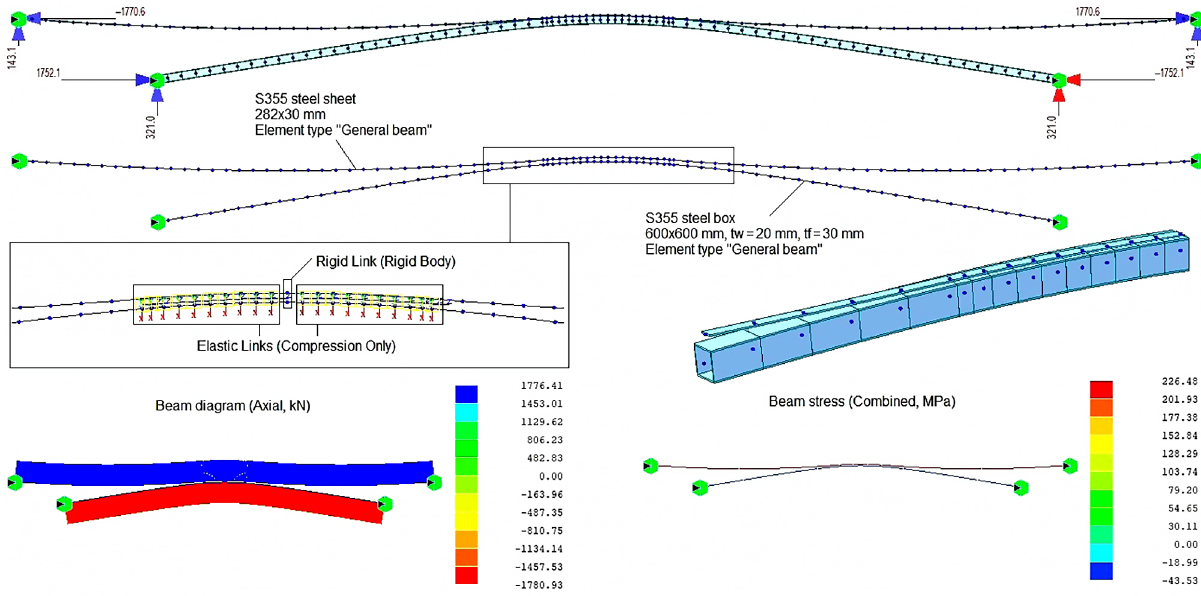
Figure 5. The bearing reactions of the nonlinear FEM analysis of the equilibrium composite structure: stress ribbon section 1770.6 kN; arched section 1752.1 kN